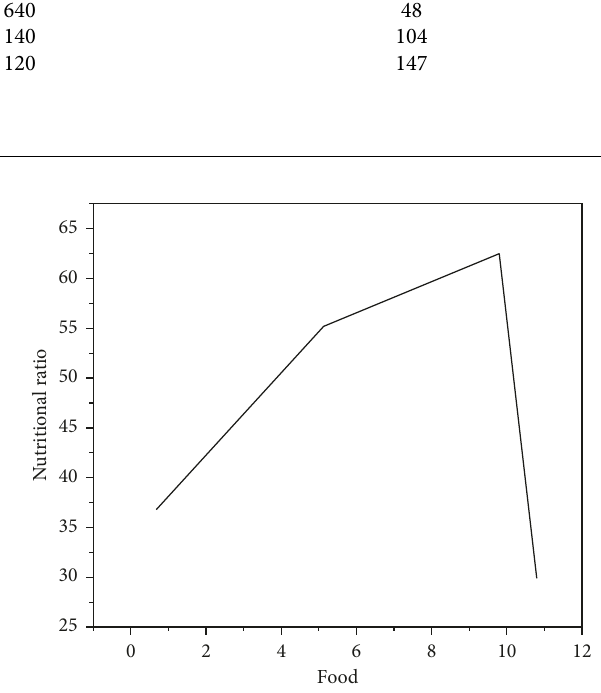
Figure 3: How to address the nutrition of athletes during travel (%).